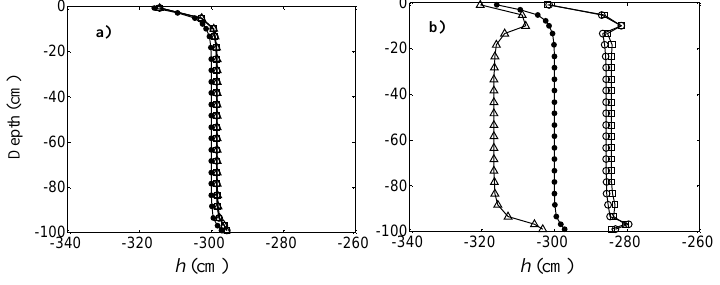
Figure 3. UKF-NL a priori estimates of the state mean after 1h, computed with ρ =0.05 (open circle), ρ =0.3 (open square) and ρ =0.8 (triangle), and adopting initial variances respectively equal to (a) 10 3 cm 2 and (b) 10 4 cm 2 on the diagonal elements of the state covariance matrix. The figure also shows the corresponding central state profiles (closed circle) propagated through the dynamic model on the same simulation time.